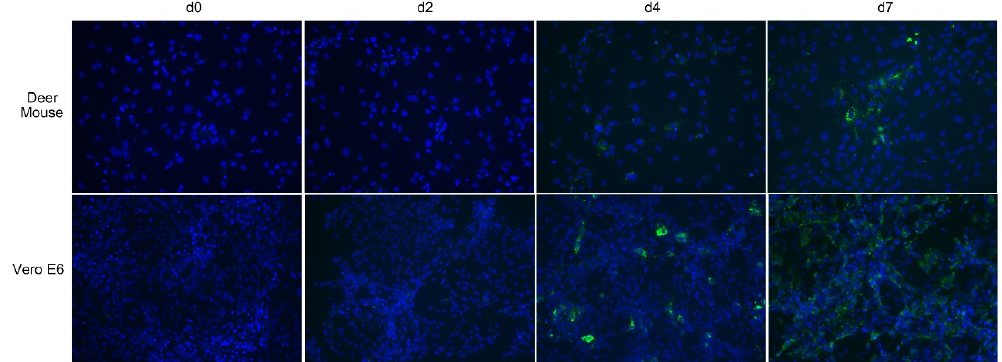
Figure 4. Maporal virus infects deer mouse cells. Deer mouse pulmonary microvascular endothelial cells (PMVEC) or Vero E6 cells were inoculated with 0.1 MOI of MAPV. On days 2, 4 and 7 cells from each were fixed and stained with rabbit antibody specific to nucleocapsid and detected with a mouse anti-rabbit IgG-FITC conjugate (green). Slides were mounted with DAPI to identify nuclei (blue). Viral antigen was detected in some deer mouse PMVEC on day 4 but substantially more cells by day 7, and with punctate characteristics. Virus was detected in few Vero E6 cells on day 2, but on day 4 punctate cells were readily observed. By day 7, many more cells were infected but the pattern was more diffuse and less puntate.